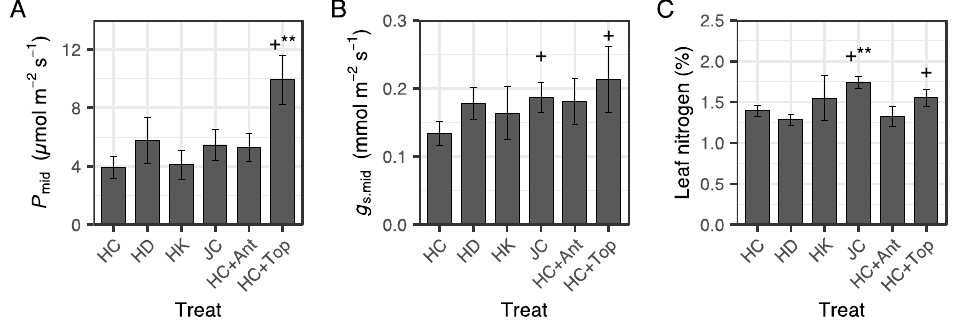
Figure 6. Mean values ± standard error (SE; n = 4 or 5) for photosynthetic rate ( P mid , ( A )) and stomatal conductance at midday ( g s.mid , ( B )) and leaf nitrogen ( C ) of container seedlings grown in Hiko-V-120 (H) and JFA-150 (J) containers with control irrigation and fertilization (HC and JC), dry irrigation (HD), high-potassium fertilization (HK), application of antitranspirant (+Ant), and topping (+Top). Measurements were taken at >300 µ mol m − 2 s − 1 of photosynthetic photon flux density (PPFD) from sunlight and 22.8 ◦ C–25.7 ◦ C leaf temperature on a sunny day in September, two months after summer planting. The plus sign indicates positive effects compared with the HC treatment in the generalized linear mixed model. ** p < 0.01.